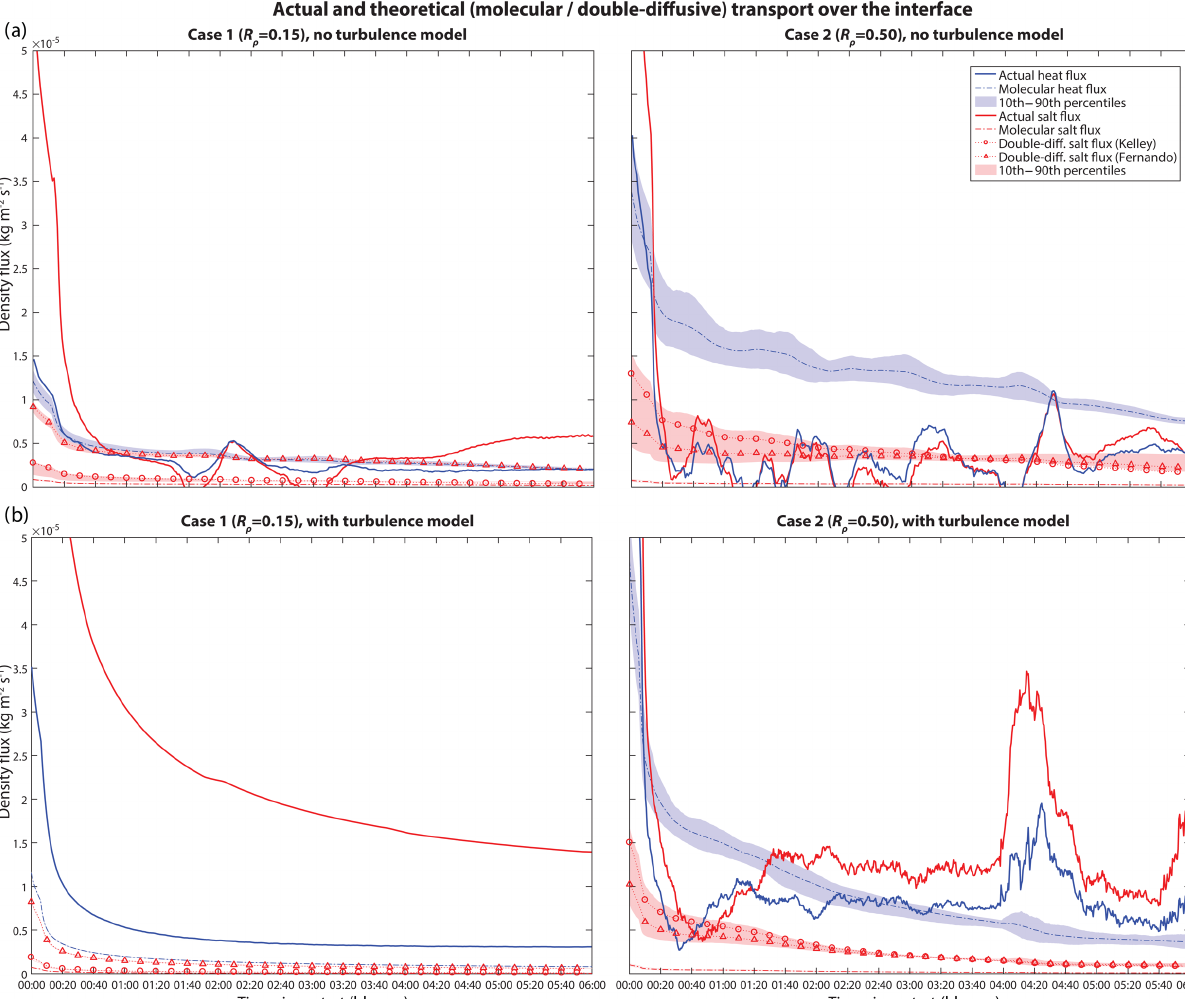
0 . 15 (Case 1, left) and R ρ 0 . 50 = =